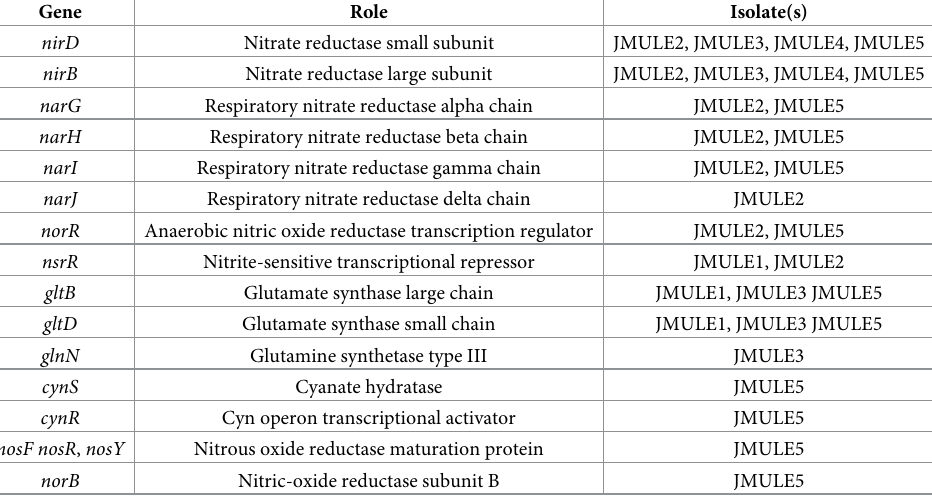
Table 3. Nitrogen genes called by RAST and PGAP and their roles in the bacterial